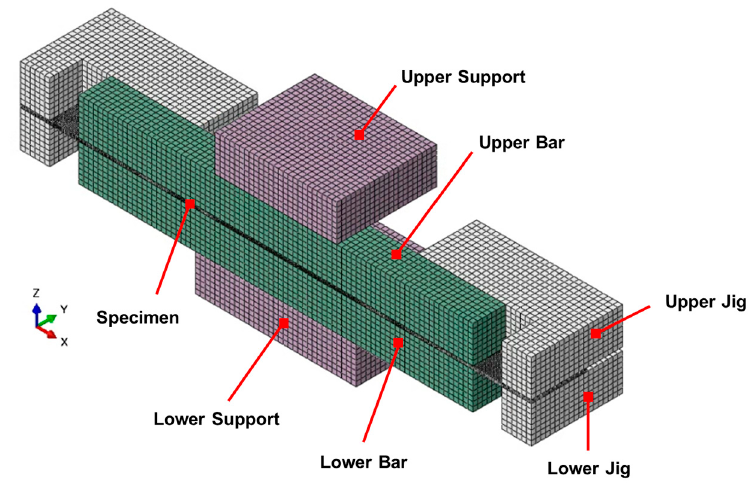
Figure 4. Finite element model of the sheet compression test. The stress and strain were measured using the same method used in the